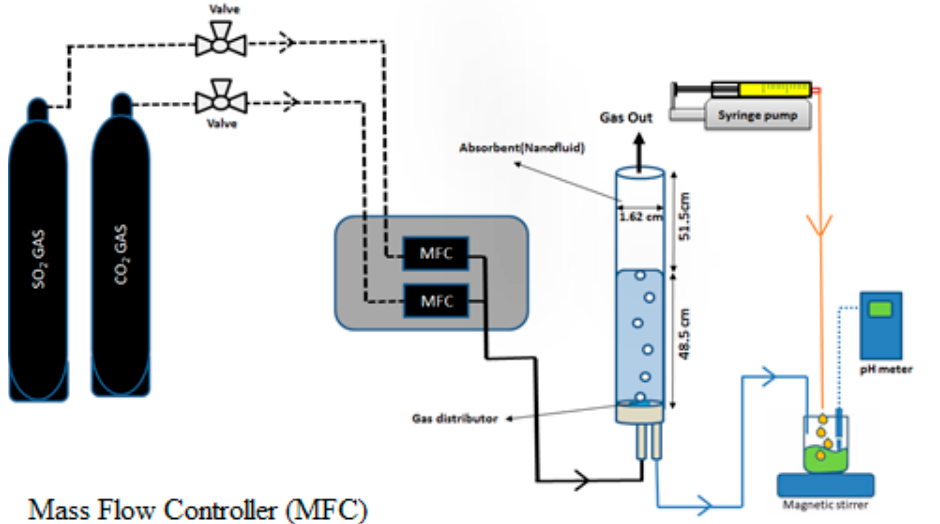
Figure 1. Schematic diagram of experimental set-up.